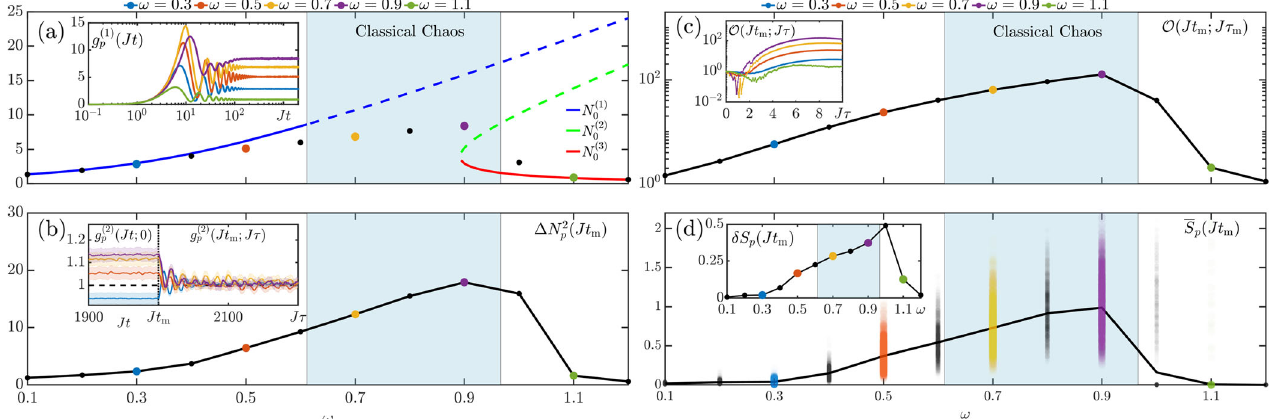
Fig. 5 Correlation functions and entanglement entropy. The main panels show the dependence on the drive frequency ω of: a the g ð 1 Þ p ð Jt m Þ photonic correlator (colored points) versus the analytical stable (solid line) and unstable (dashed line) fi xed points N ð ν Þ ð Jt Þ ; c the OTOC Oð Jt ; J τ Þ saturation value; ( d ) the trajectory-averaged entanglement entropy S uncertainty of the occupation Δ N 2 m m m p (black line), with the contribution of individual trajectories denoted by colored points. The classical chaos region is shaded in blue. The insets show: a the g ð 1 Þ p ð Jt Þ correlator as function of Jt ; b the left side (with respect to the dashed vertical line) presents g ð 2 Þ p ð Jt ; 0 Þ correlator as function of Jt while the right side presents g ð 2 Þ p ð Jt m ; J τ Þ as function of J τ ; c the time-dependence of Oð Jt m ; J τ Þ as function of J τ ; d the variance over different trajectories of the entanglement entropy δ S p ( Jt m ) as function of the drive frequency ω . Here u = 0.1, γ = 0.05, d = 0.3, t m = 2000/ J (corresponding to steady state) and τ m = 10/ J (corresponding to saturation).